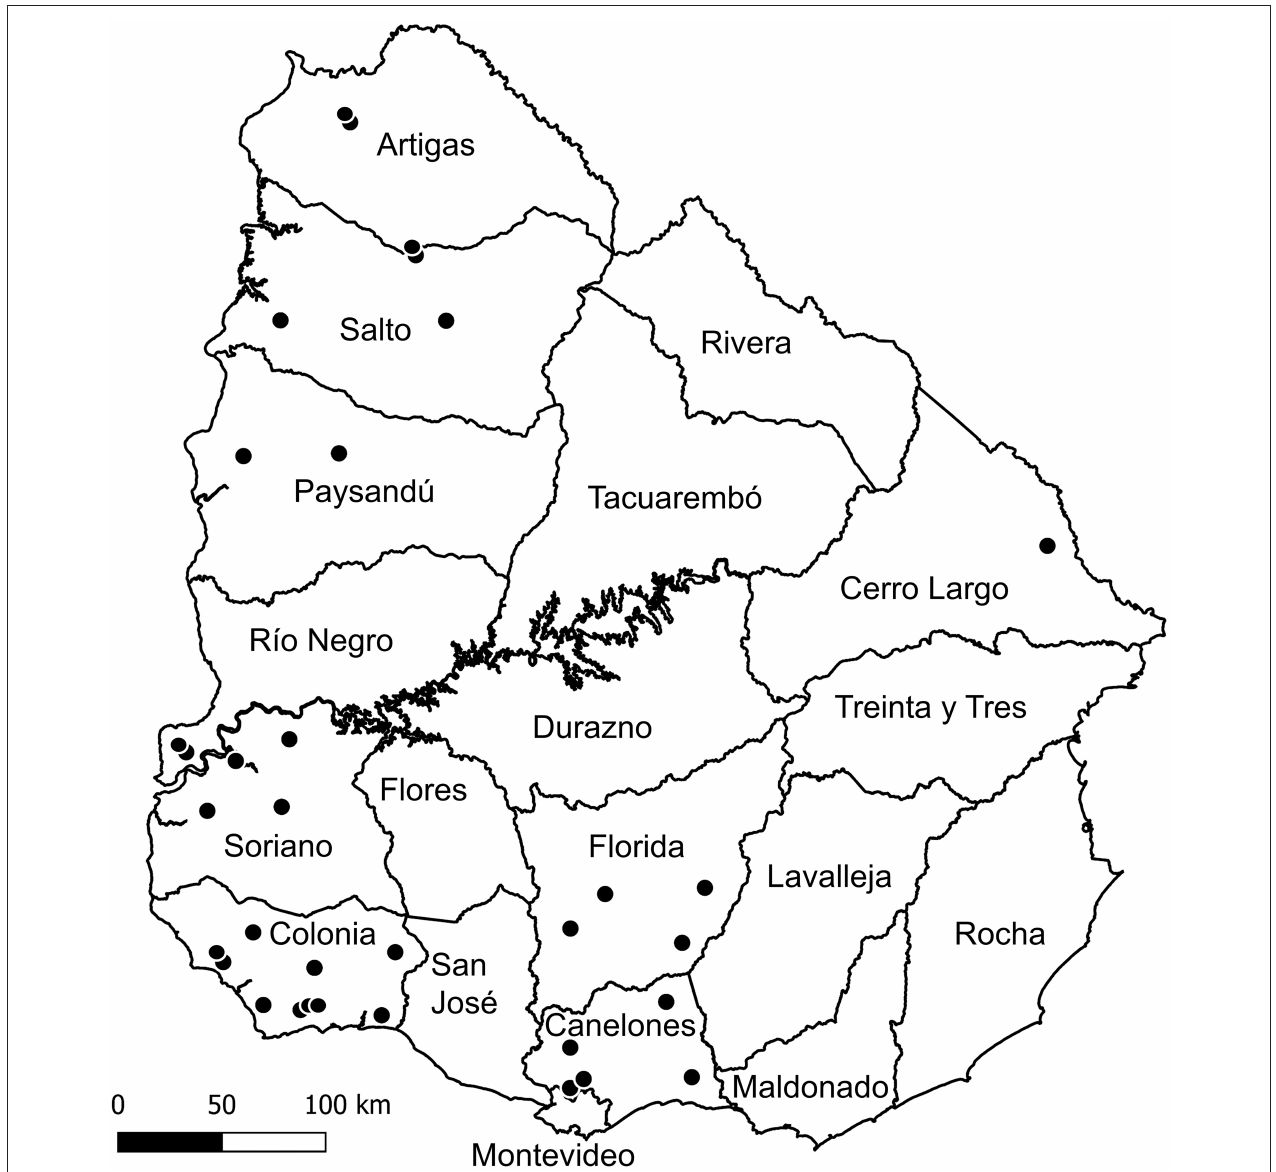
FIGURE 1 | Map of Uruguay showing the geographical location of the 34 farms (black dots) submitting cases by department. The map was created with QGIS software version 2.14 (http://qgis.osgeo.org).